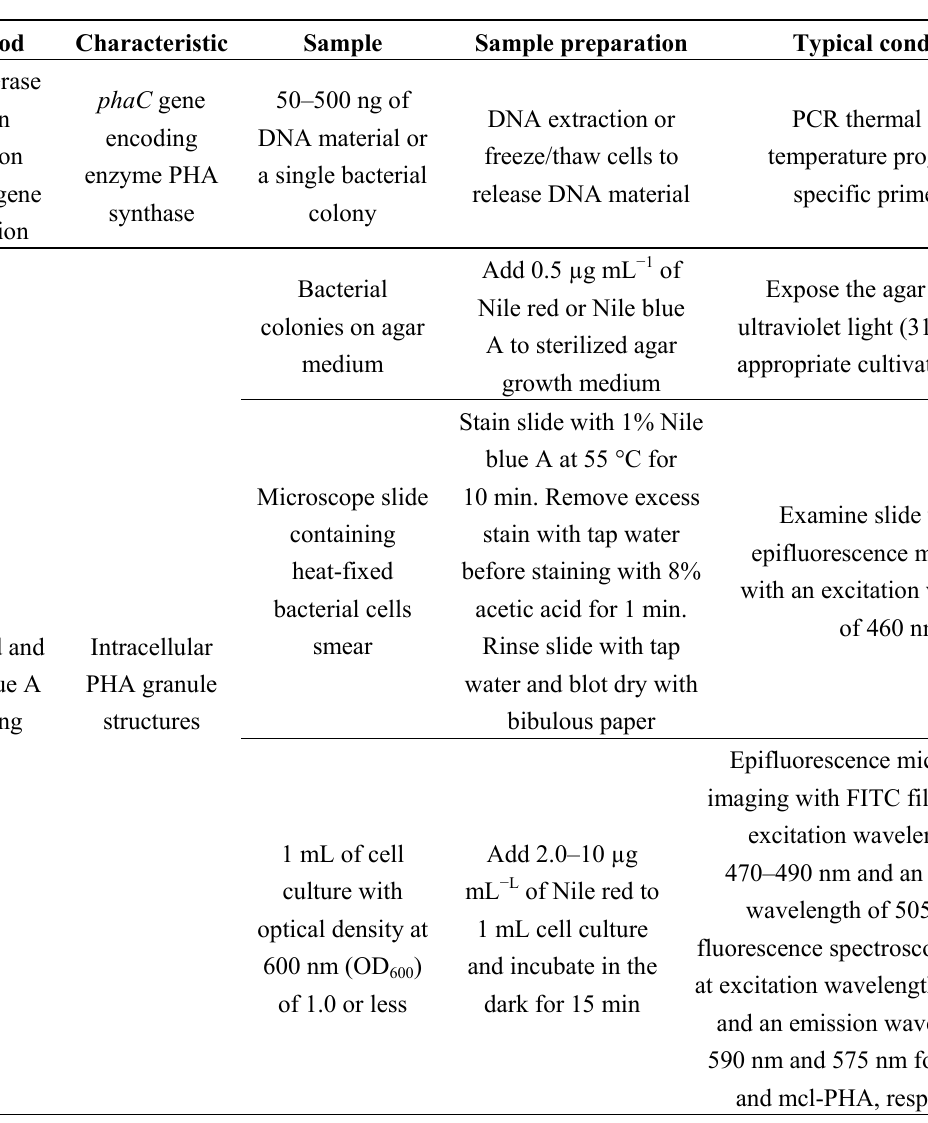
Table 3. Methods for detection of PHA in biomass and PHA production